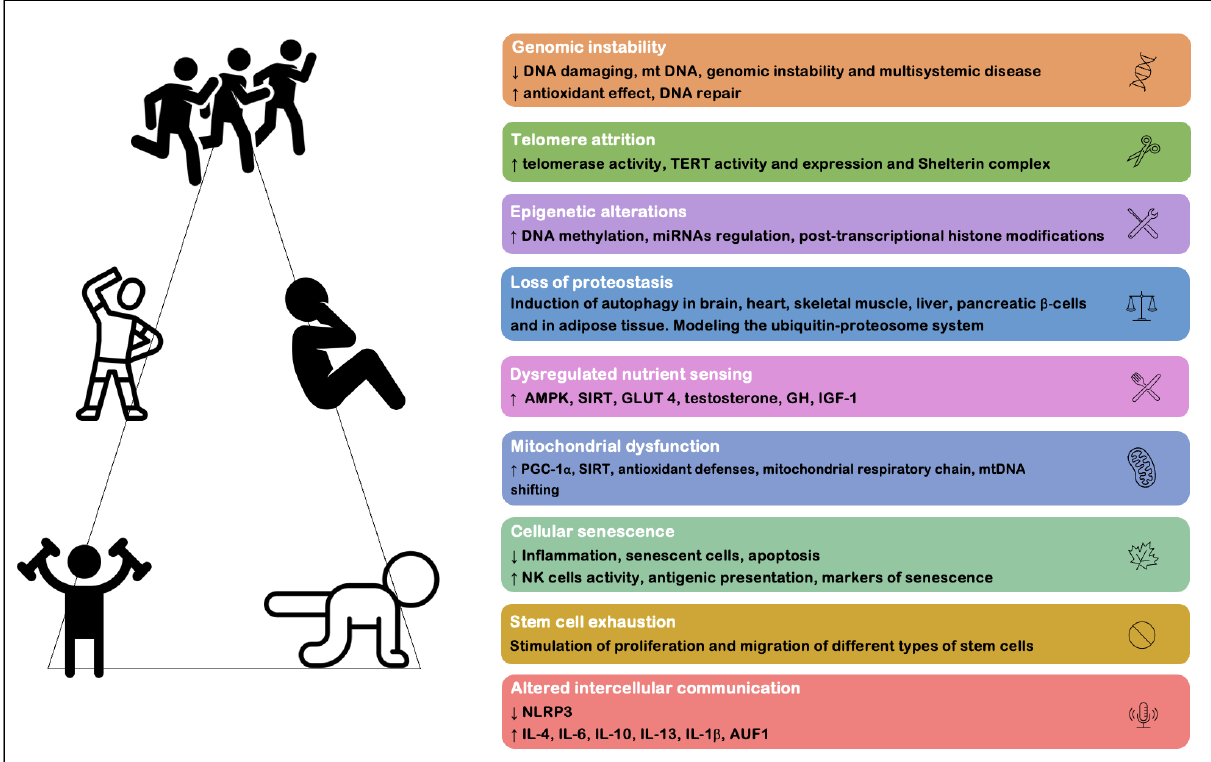
Figure 1. Benefits of exercise on nine cellular and molecular markers of aging (adapted from Rebelo- Marques et al. [7] and Garatachea et al. [8]). Abbreviations: AMPK, 5 (cid:48) adenosine monophosphate activated protein kinase; AUF1, AU binding factor 1; DNA, deoxyribonucleic acid; GH, growth